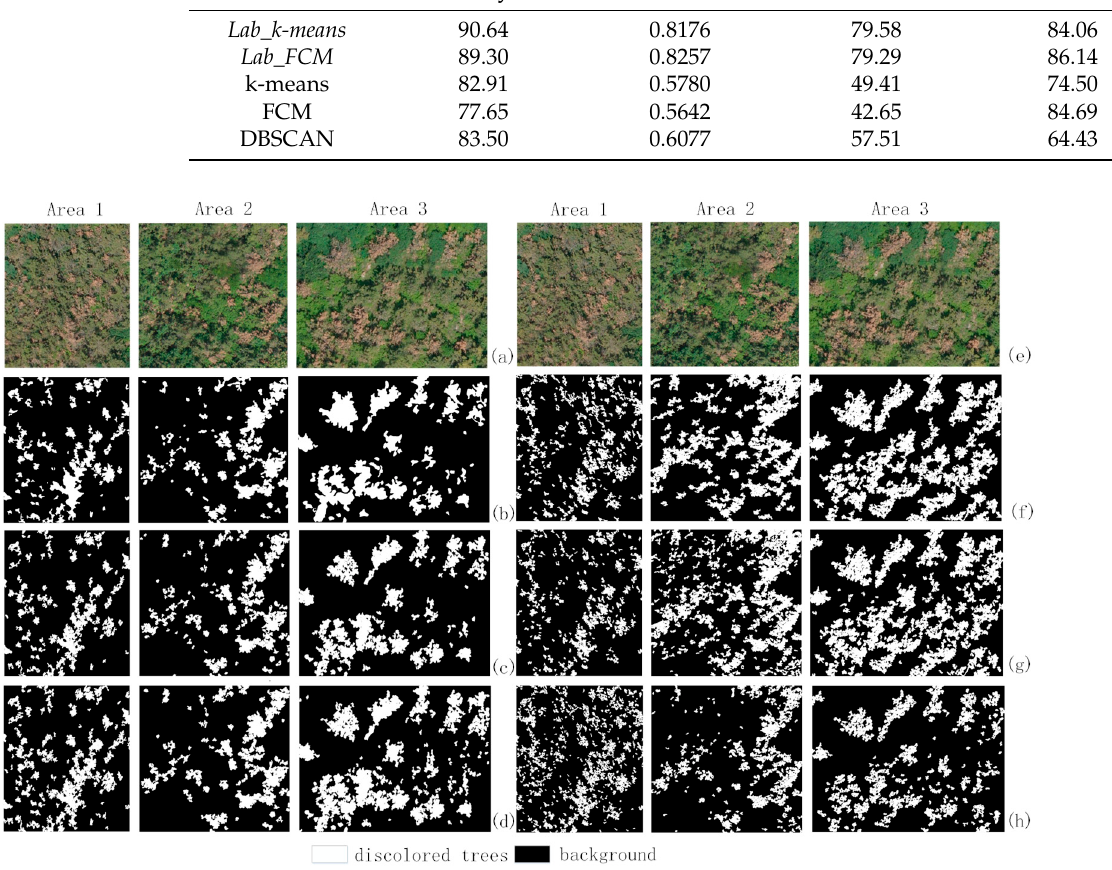
Figure 7. Extraction results by different methods. ( a ) UAV image; ( b ) ground truth; ( c ) Lab_k-means; ( d ) Lab_FCM; ( e ) UAV image; ( f ) k-means; ( g ) FCM; and ( h ) DBSCAN.